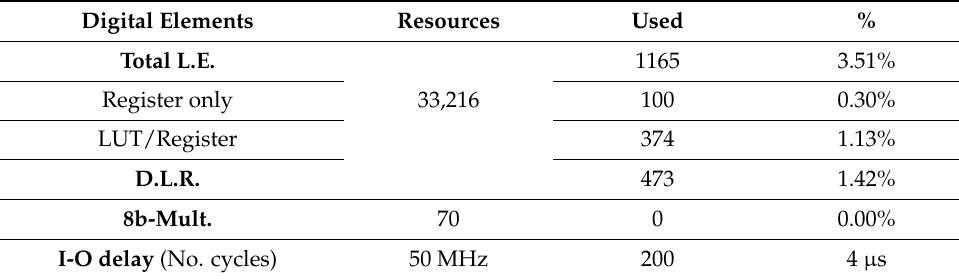
Table 8. Hardware resources used by DTSTC